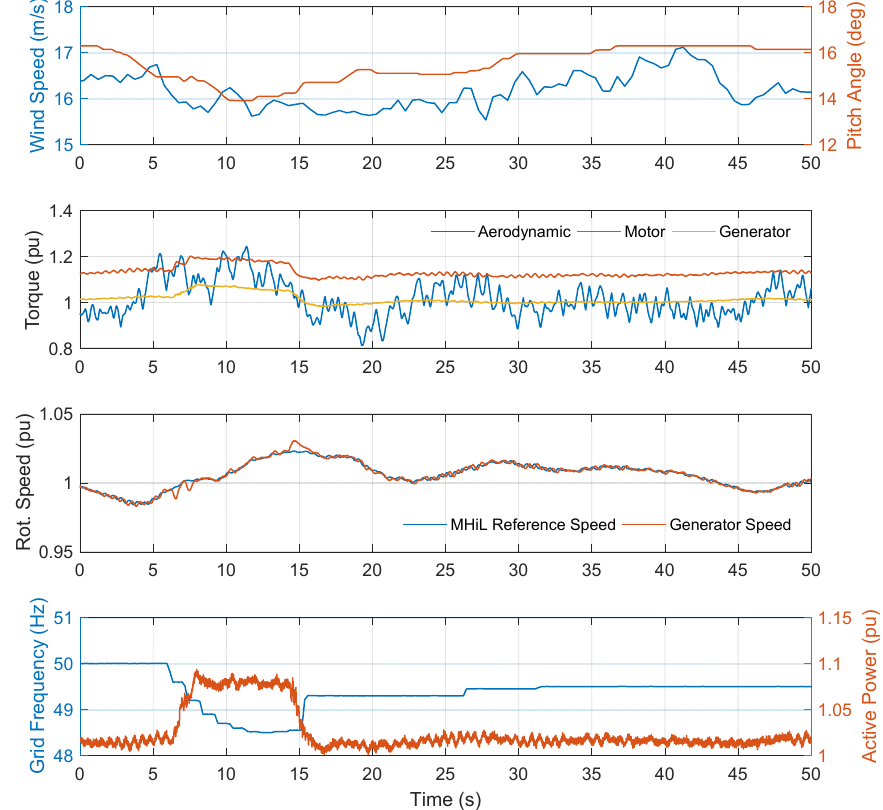
Figure 15. Synthetic inertia test according to IEC61400-21-1.